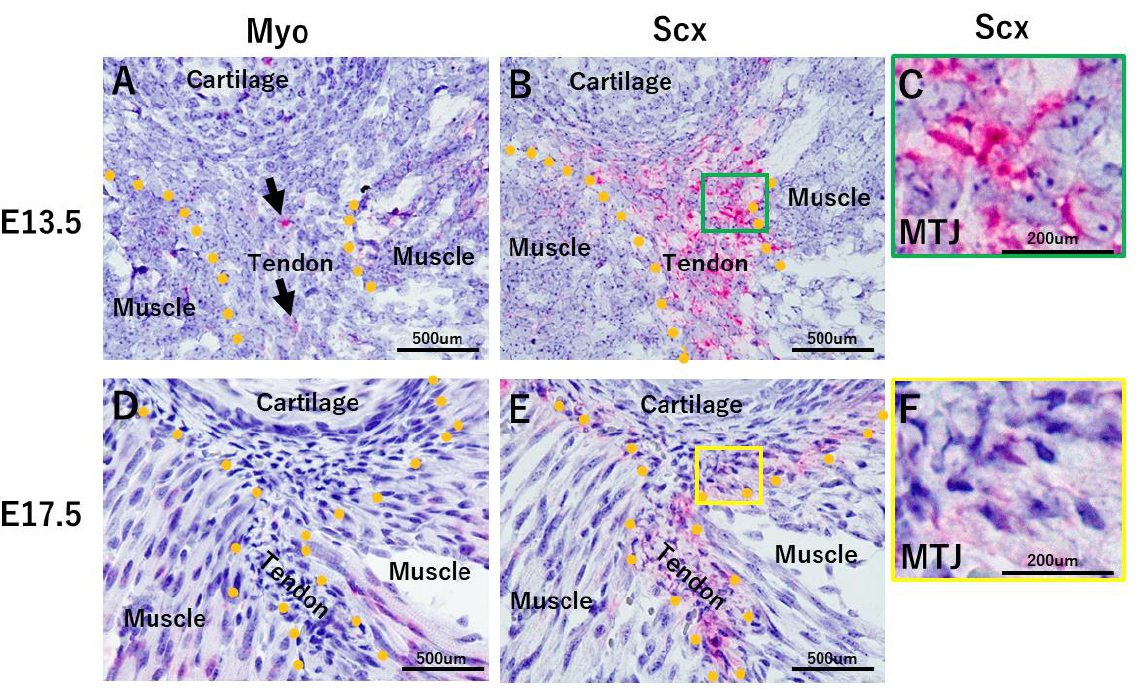
Figure 2. On embryonic day (E) 13.5, Myo is expressed in myoblast cells and a few tenoblast cells (two arrows) ( Panel A ). Tenoblast cells clearly express Scx ( Panel B ). On E17.5, myotube expresses Myo ( Panel D ). Tendon shows Scx expression ( Panel E ). There are numerous Scx-positive cells ex- hibiting a round nuclear morphology ( Panel C ). On E17.5, many Scx- positive cells exhibit spindle- shaped nuclei ( Panel F ). E13.5: n = 3, E17.5: n = 3. Squares in Panels B , E correspond to Panels C , F .